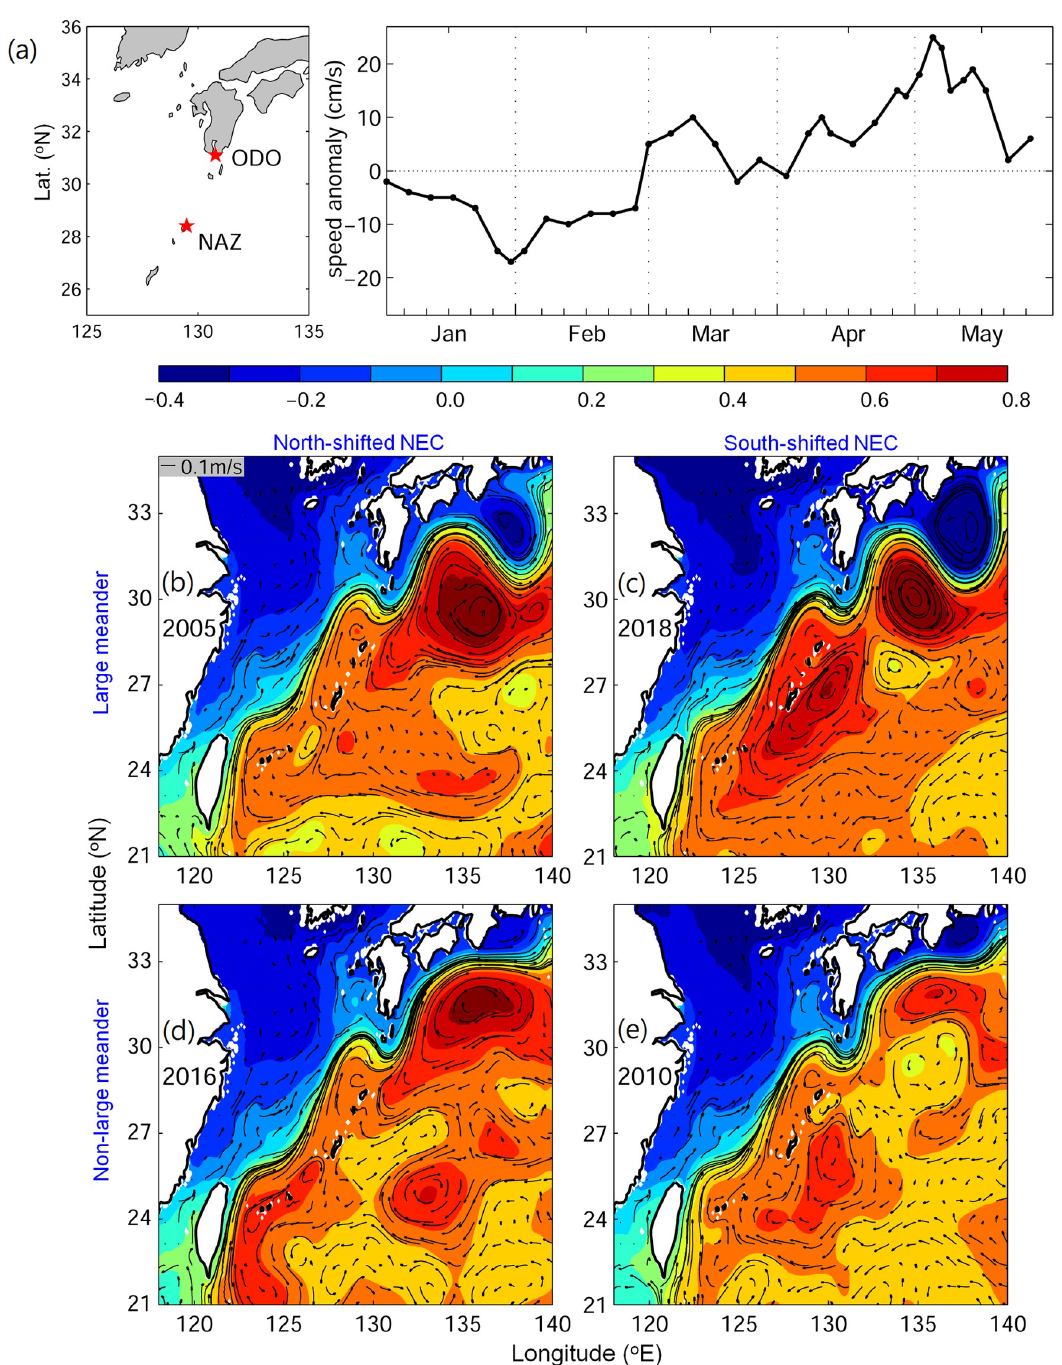
Fig 8. The 2018 Kuroshio geostrophic velocity anomaly (cm/s) south of Japan derived from tide gauge stations Oodori (ODO) and Naze (NAZ) (a). Plots of the sea surface height (b − e, color shading shows height in meters) and 50 − 250 m averaged ocean currents (vectors, m/s) in the late recruitment season (period 3, February to April). Red shading and clockwise circulation often indicate the presence of warm eddies, and blue and anti-clockwise circulation corresponds to cold eddies.